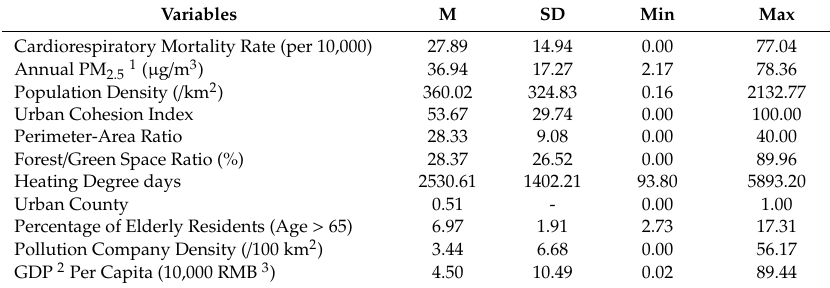
Table 2. Descriptive statistics (N =